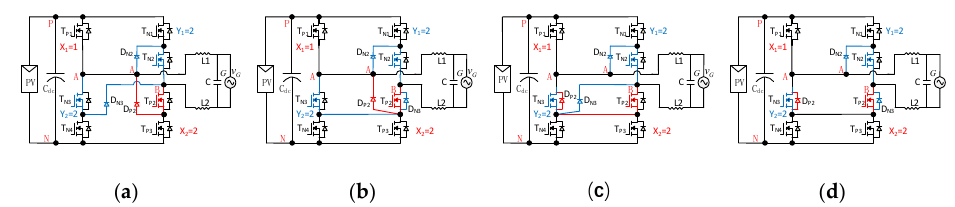
Figure 16. Two topologies derived from X 1 = 1, X 2 = 2, Y 1 = 2, and Y 2 = 2. ( a ) R9 (new); ( b ) R10 (circuit one); ( c ) R10 (circuit two); ( d ) R10 (circuit three) (new). Correspondingly, two topological families under M = 3 and N = 4 or M = 4 and N = 3 are shown in Table 4. Table 4. Topological families under M = 3 and N = 4 or M = 4 and N = 3. Family with Extra Family without Extra Diode